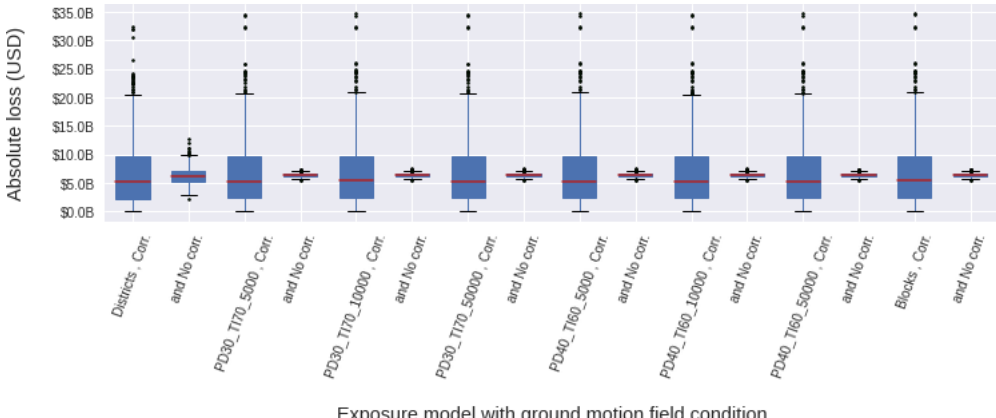
Figure 12. Computed loss distributions from a M w 8.8 scenario for the residential building stock of Lima classified in terms of the SARA vulnerability classes aggregated into eight geographical entities. Two ground motion field conditions are analysed in every case, namely with the selected cross-correlation model (Corr.) and with uncorrelated ground motion fields (No